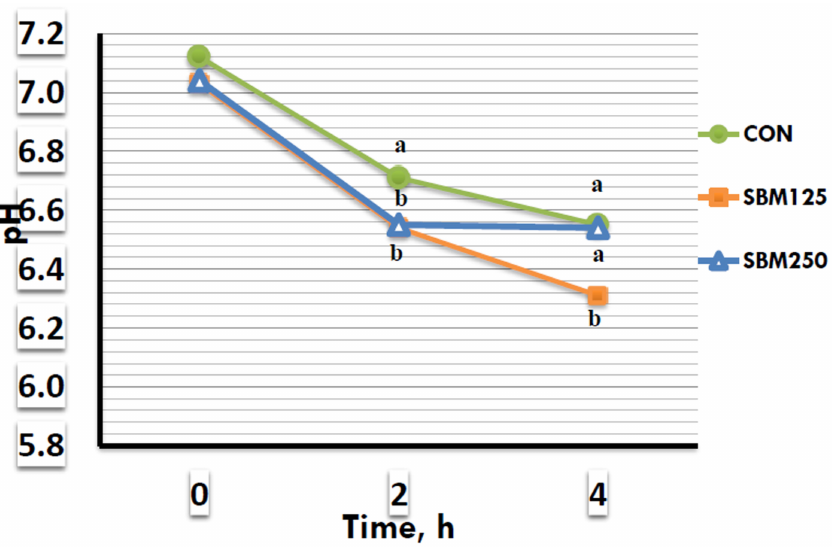
Figure 1. E ff ect of protein supplementation on rumen fluid pH of Awassi lambs fed low-quality forage